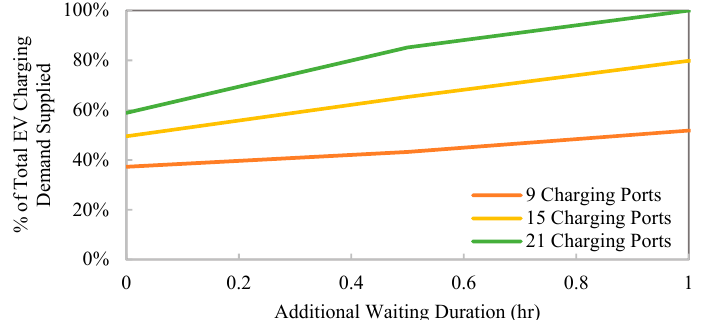
Figure 9. Comparison of delivered charging to EV fleet considering different sizing of charging ports.